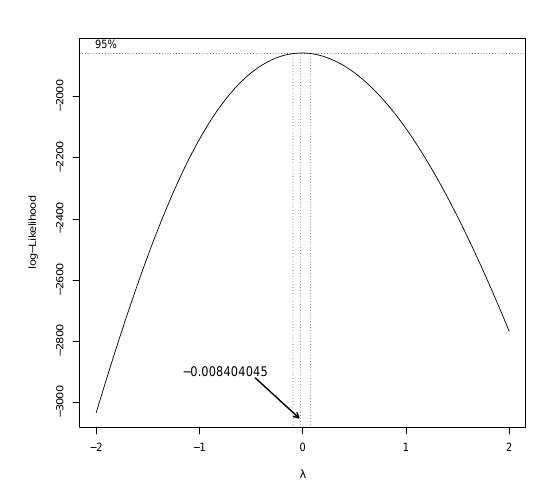
Figure 2 – Pro(cid:12)le Log-likelihood for Box-Cox transformations